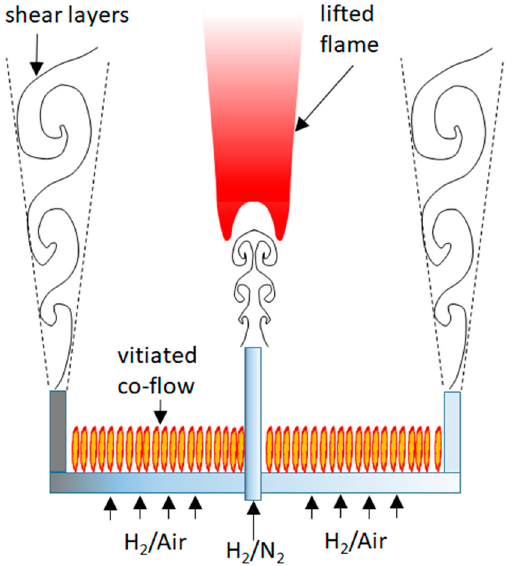
Figure 2. Sketch of experimental set-up of Wu et al. [19,23].